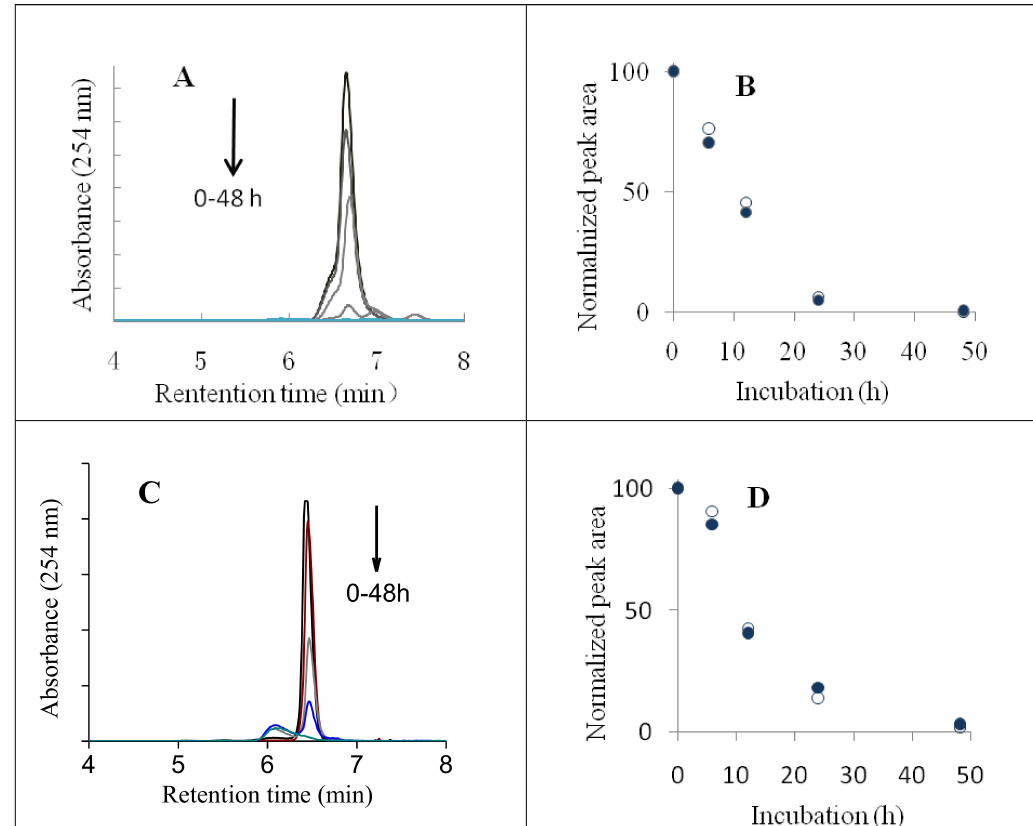
Figure 1. Analysis of AsA degradation. ( A ) HPLC analysis of the kinetics of AsA degradation at 37 ◦ C and pH 7.4, and ( B ) the corresponding time-dependent change in the peak area of AsA. The kinetics of AsA degradation at 60 ◦ C and pH 2.0 and the corresponding time-dependent change in peak area are shown in ( C ) and ( D ), respectively. HPLC analyses were performed in duplicates. All data are shown in ( B ) and ( D